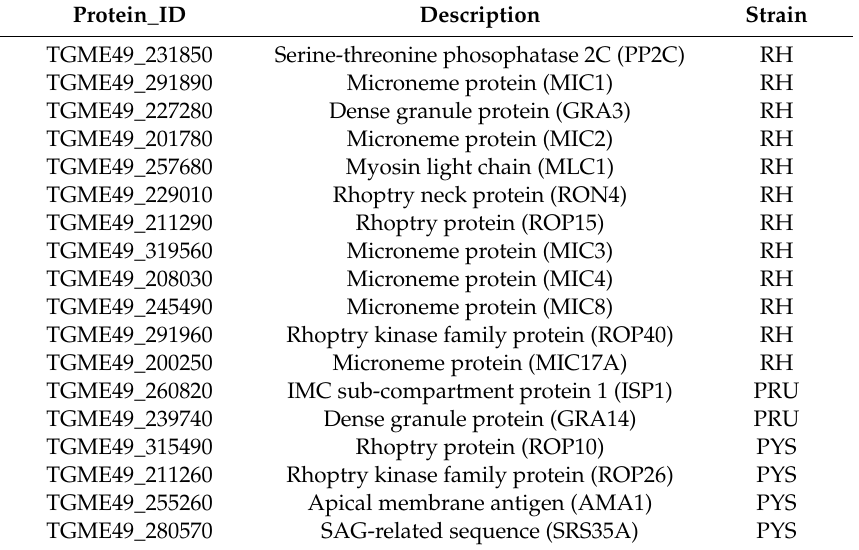
Table 1. Virulence factors exclusively acetylated in RH strain, PRU strain and PYS strain. Protein_ID Description